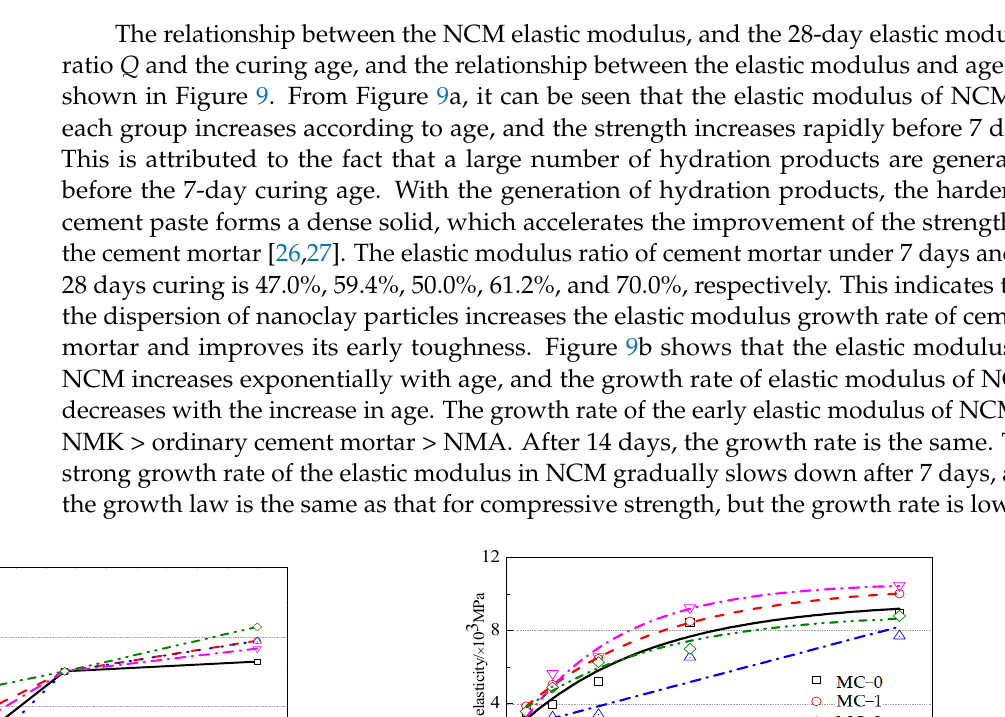
Figure 9. The relationship between the elastic modulus and curing age.( a ) Q ; ( b ) E cu . According to the above results, NMK with stable dispersion improves the flexural strength, compressive strength, and elastic modulus of cement mortar. Because it is easy to re-agglomerate, the mechanical properties of the cement mortar are reduced. After NMK is dispersed, the clay particles can effectively fill the pores generated during the cement hydration process, making the internal structure of the cement mortar specimen more compact. Nanoclay particles with smaller particle sizes can effectively fill the larger pores of the cement mortar matrix, promoting the hydration reaction process of the cement mortar, increasing the hydration products, and causing the cement mortar to form a dense and hardened slurry, thereby improving the mechanical properties of the cement mortar.